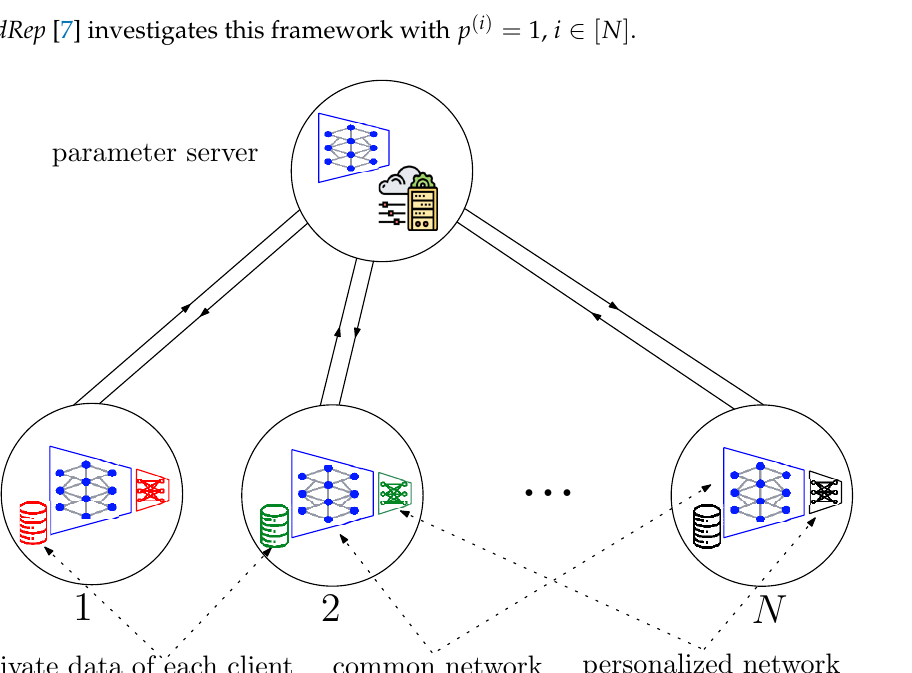
Figure 1. Personalized federated learning (PFL) framework with a common network (shown in blue) and small personalized headers (shown in red, green,